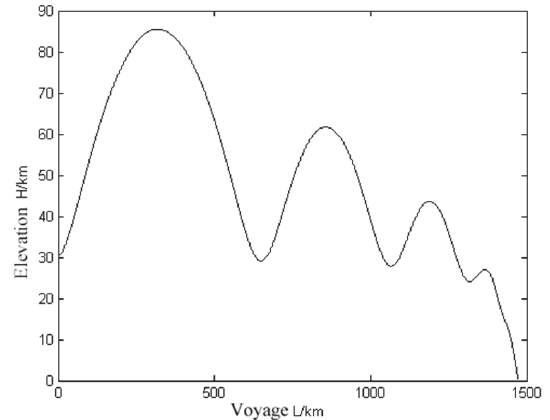
Figure 1: Target trajectory.